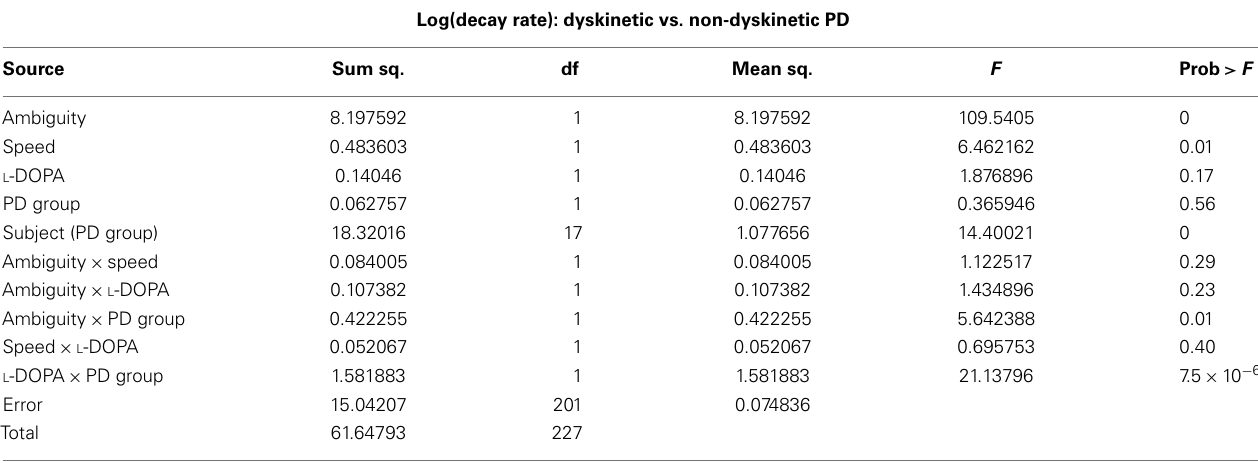
Table 4 | Mixed-model analysis of variance (ANOVA) table to assess different effects on overall log(decay rate) in PD subjects . Log(decay rate): dyskinetic vs. non-dyskinetic PD